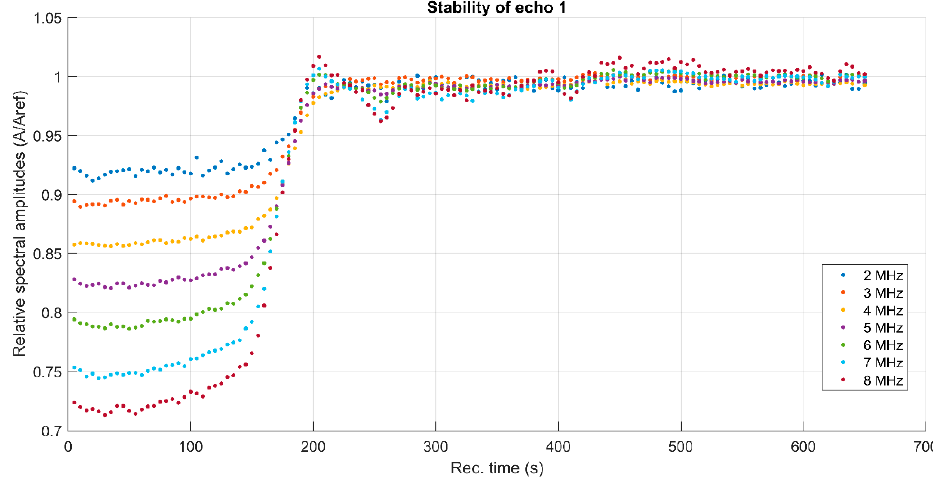
Figure 5. Spectral amplitudes relative variation vs. time, for the first echo.